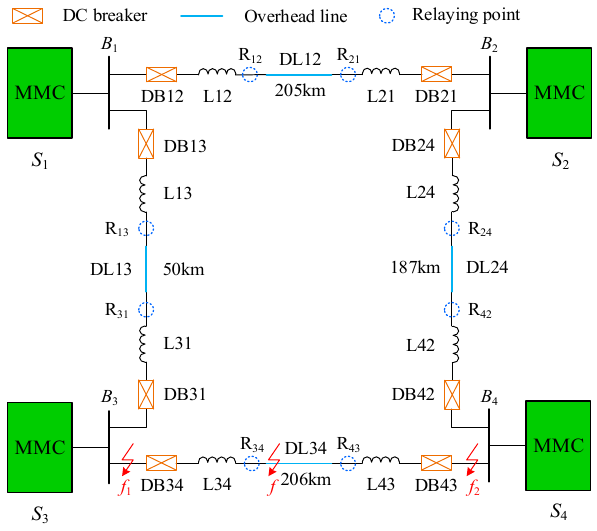
Figure 14. ± 500 kV four-terminal voltage-sourced converter (VSC)-based DC grid.